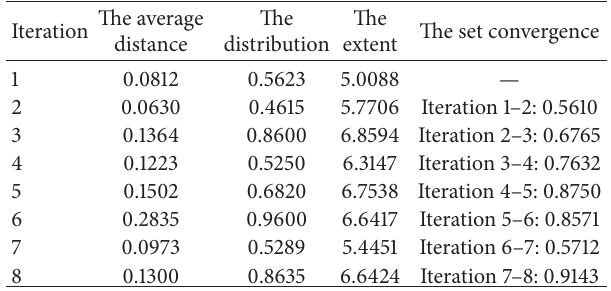
Table 8: Metrics of performance and set convergence for Pareto optimal sets.